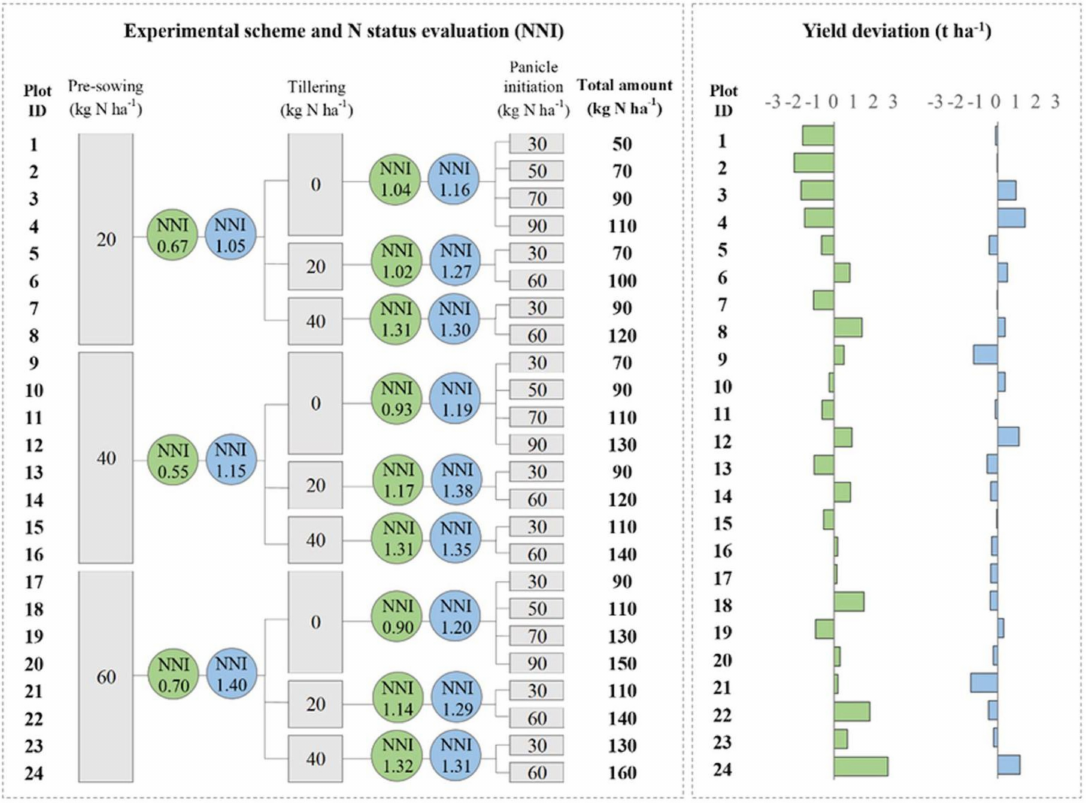
Figure 1. Experimental design (left panel) and yield deviations compared to the field mean (right panel) for the experiments performed in 2014 in Rosasco and in 2015 in Gaggiano (experiment 1 and 2 in the text, respectively). In circles: nitrogen nutritional index (NNI) values derived using the PocketN and PocketLAI smart apps just before the topdressing fertilizations at tillering and at panicle